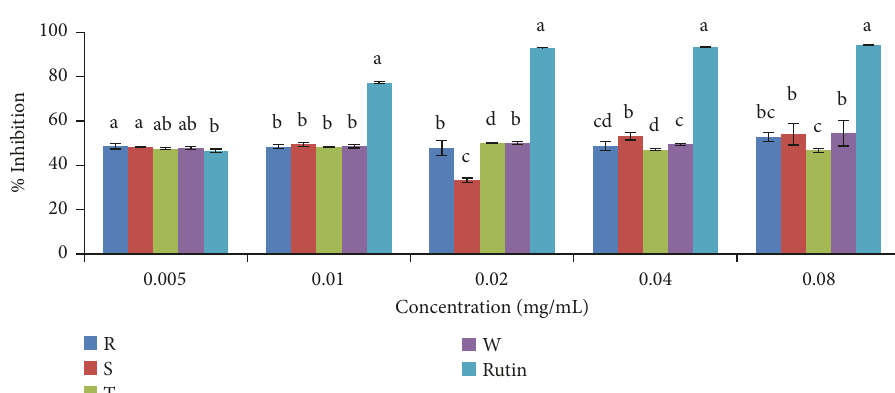
Figure 3: DPPH scavenging activity of aqueous extract of the four varieties of Capsicum species. Values are mean ± SD of three replications. Set of bars having different letters are significantly different at (p < 0.05). R= C. annuum var. abbreviatum , S= C. annuum var. acuminatum , T= C. annuum var. grossum , and W= C. frutescens var . baccatum .